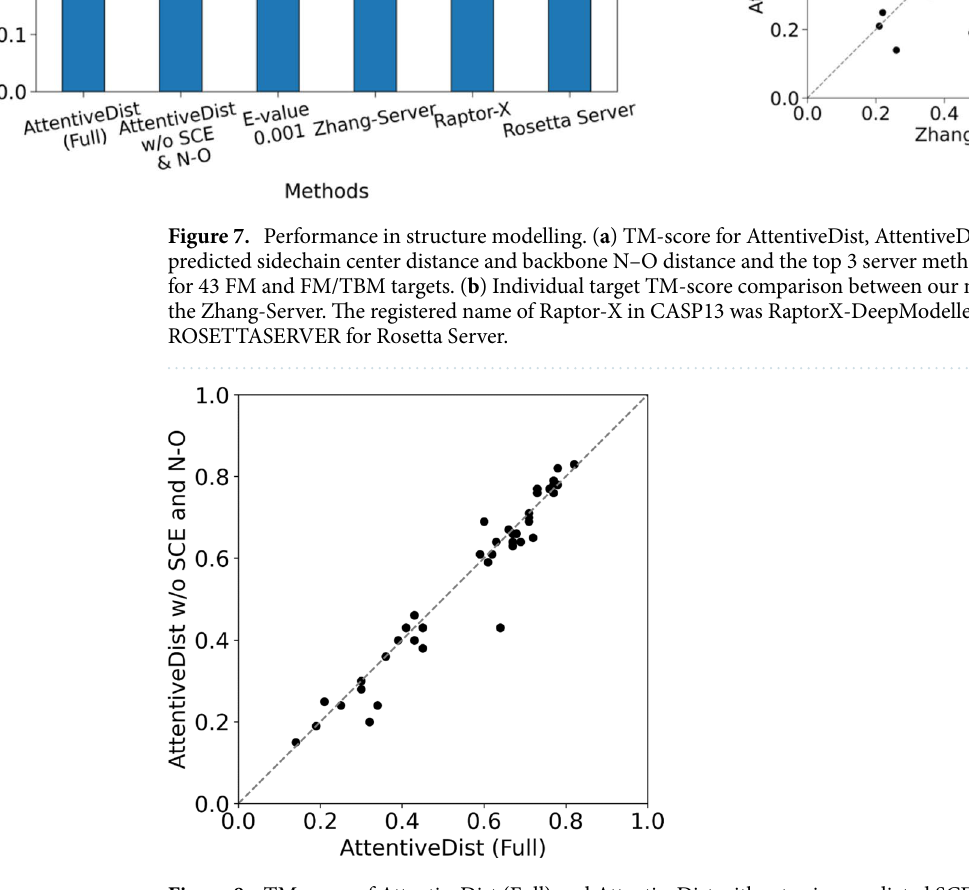
Figure 8. TM-score of AttentiveDist (Full) and AttentiveDist without using predicted SCE-SCE and N–O distances on the 43 CASP13 domains. AttentiveDist (Full) showed higher TM-Score for 19 targets, tied on 6 targets.